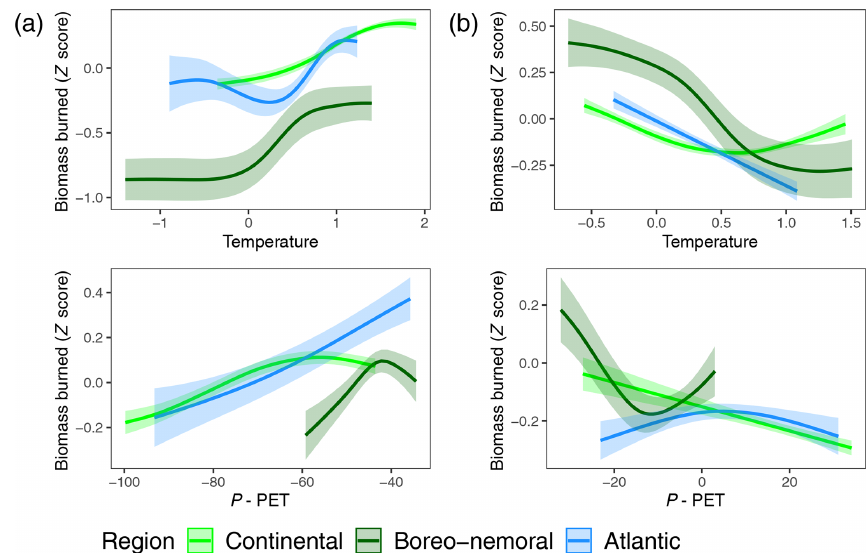
Figure A1. Fire–climate relationship in the three ecoregions of central and eastern Europe for 12–8ka (a) and 8–0ka (b) , respectively. The relationship between biomass burning, determined from Z -score composite charcoal values, and simulated seasonal summer (June, July, August (JJA)) temperatures and precipitation minus potential evapotranspiration ( P − PET) was developed from generalized additive models